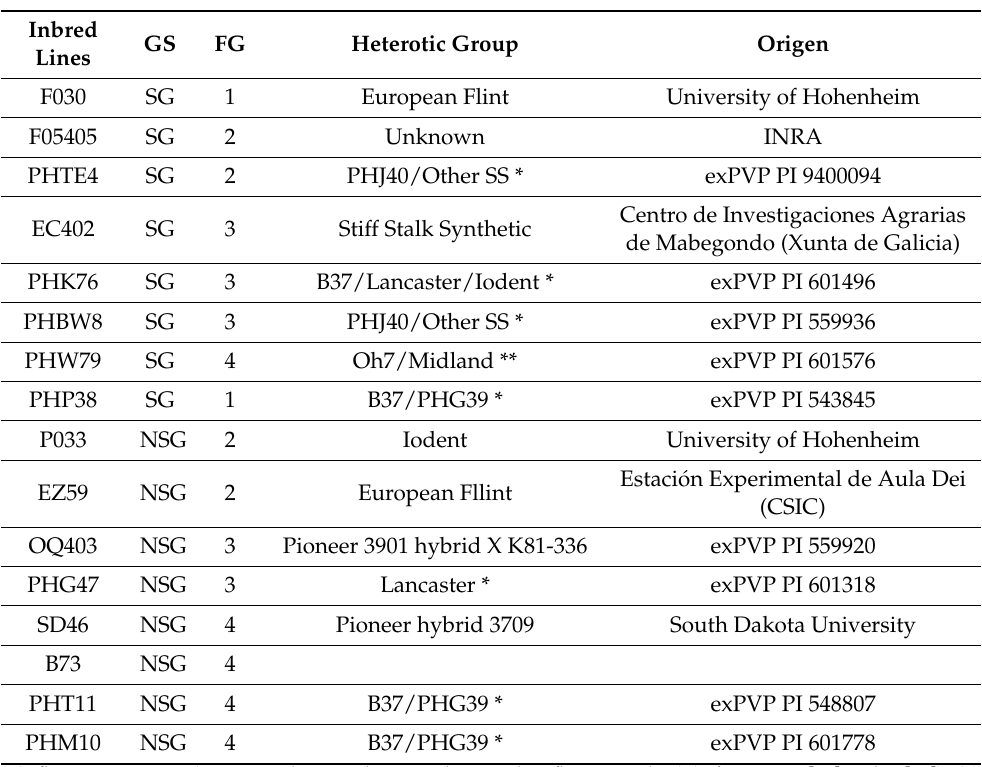
Table 1. Senescence group, flowering groups, Heterotic groups and origin of the 16 inbred lines of maize used in this